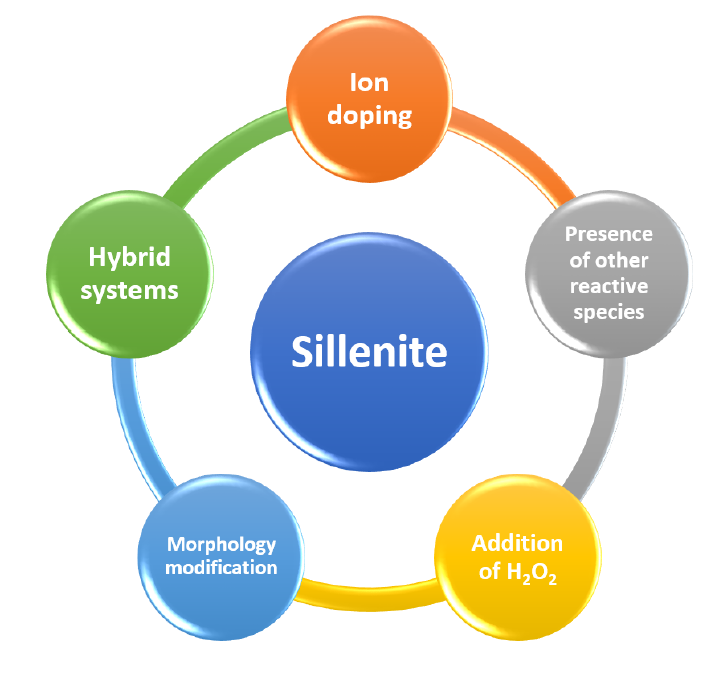
Figure 4. Various strategies used to improve the photocatalytic performance of sillenites.